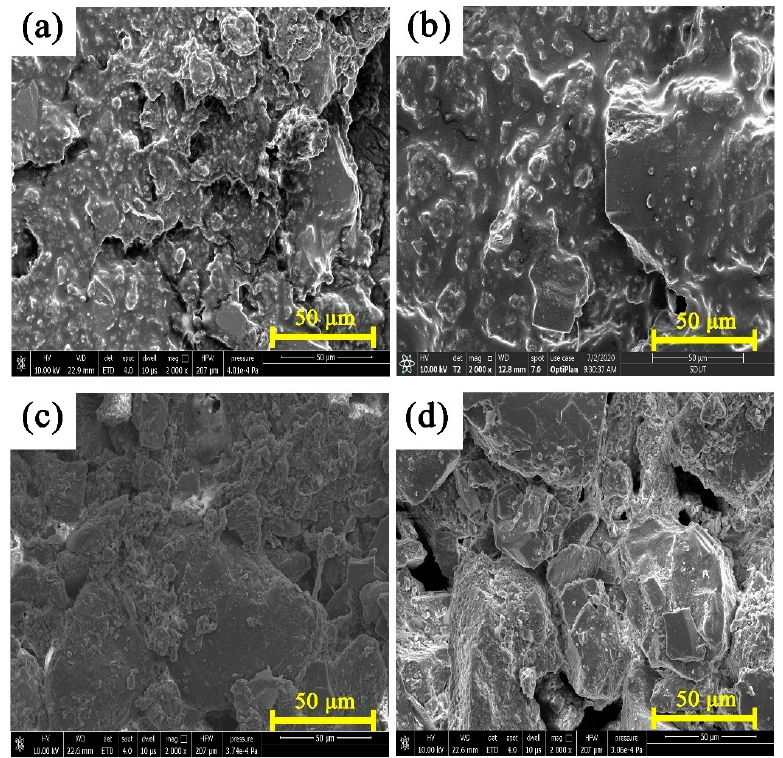
Figure 7. SEM images of ( a ) OSS, ( b ) OST, ( c ) OSS residue, and ( d ) OST residue. Flotation conditions: T t = 25 min, C c = 400 mg/L, T p = 33 °C, R s = 1340 r/min, L/OS = 12:1.